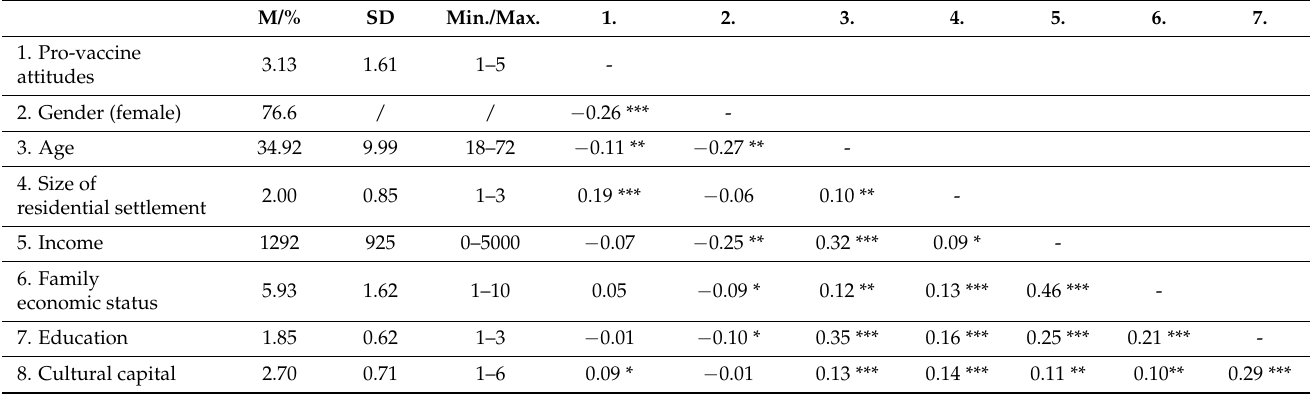
Table 2. Bivariate correlations between pro-vaccine attitudes, two cultural capital dimensions and control